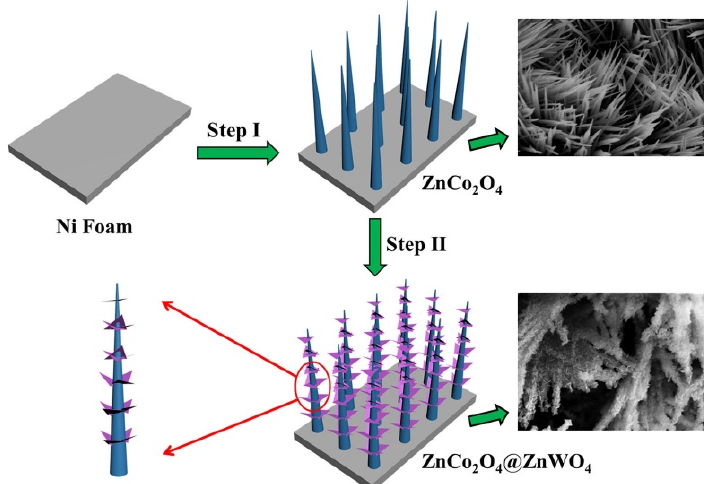
Figure 11. Schematic illustrating the fabrication process of the ZnCo 2 O 4 @ZnWO 4 core-shell nan- owire arrays on a nickel foam substrate. Reproduced with permission from Li Xie, Core-shell struc- tured ZnCo 2 O 4 @ZnWO 4 nanowire arrays on nickel foam for advanced asymmetric supercapacitors; published by Elsevier, 2018